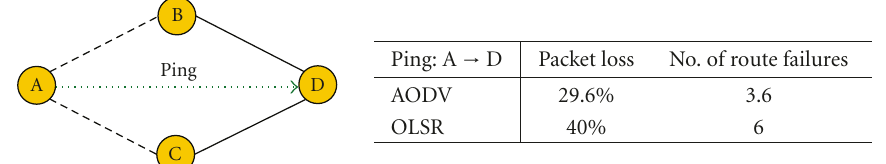
Figure 13: Network topology with two unstable links and related experimental